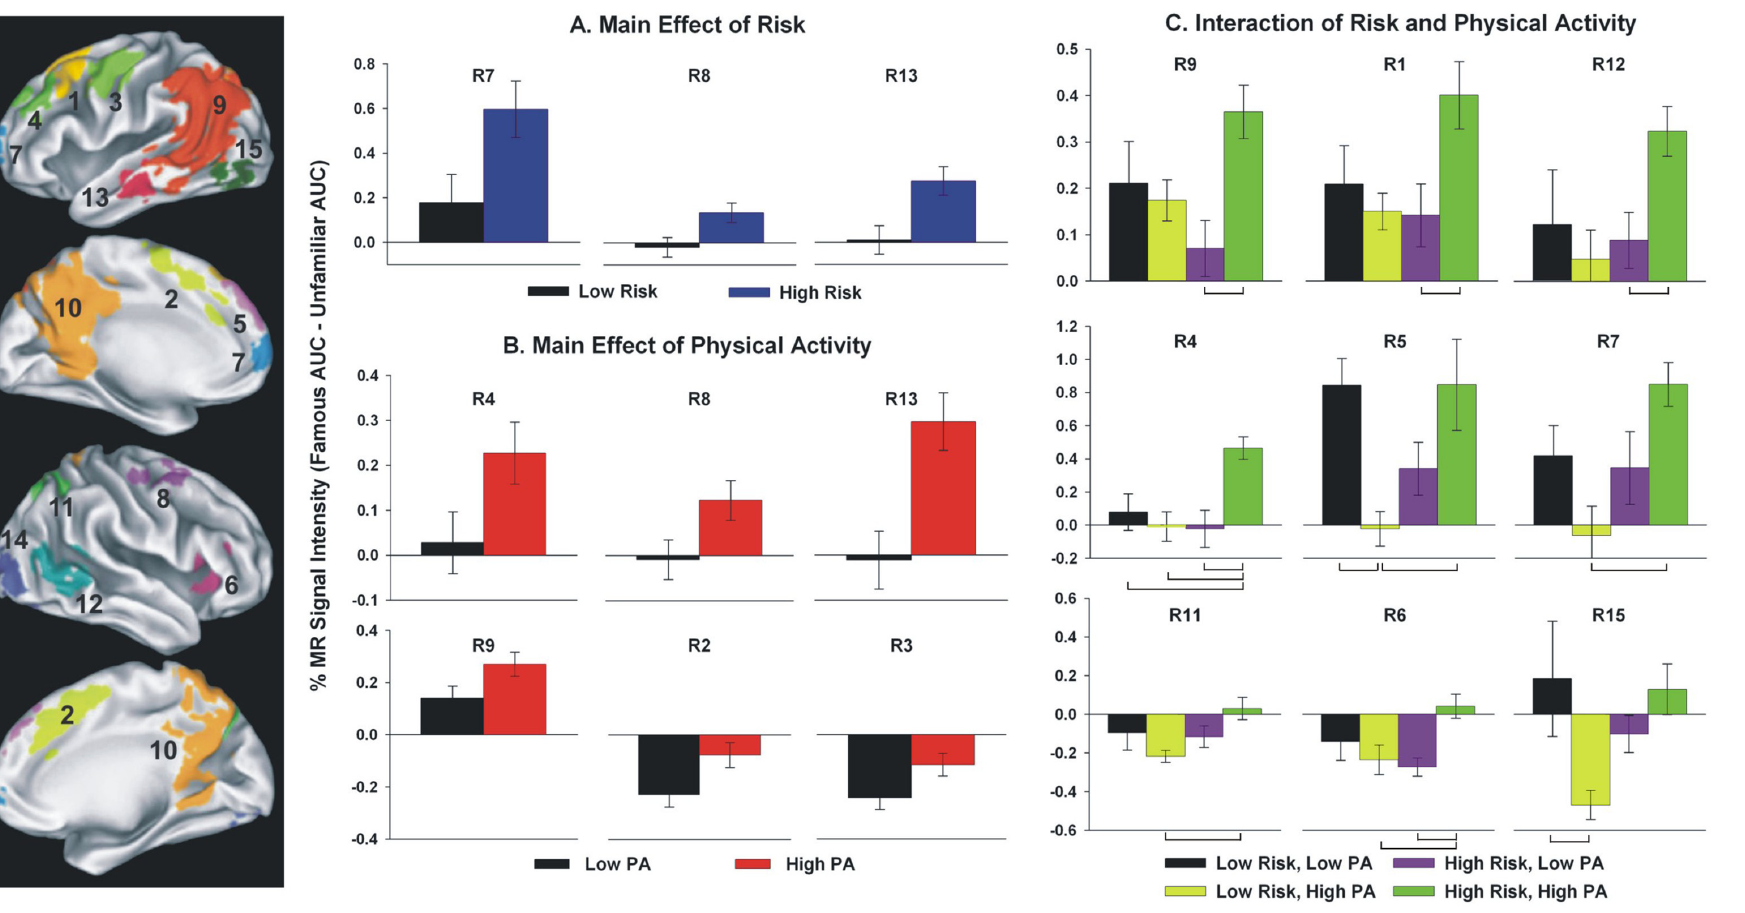
Figure 2. Fifteen functional regions of interest (fROIs) identified by Smith et al ., 2011 [107]. In the left panel, region numbers (R#) correspond with activation foci shown on the right. Bar graphs represent mean percent MR signal intensity change for main effects of Physical Activity and Risk (panels A and B , respectively) and interaction effect of Physical Activity × Risk (panel C ). Post-hoc group differences are indicated by brackets in panel C ( p < 0.01). Error bars = S.E.M. Figure reproduced with permission from [107], Copyright © 2011,